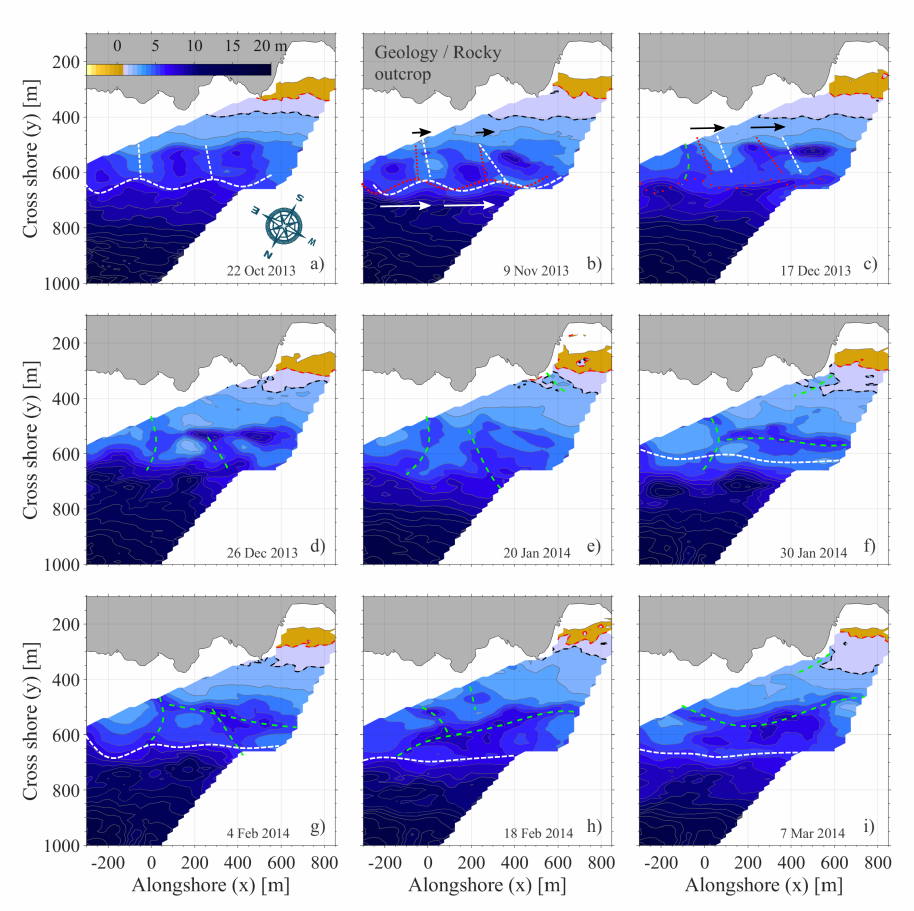
Figure 4. Video-derived bathymetry sequence, ( a – i ), covering a period starting from 22 October 2013 ( a ) to 7 March 2014 ( i ). In between this period the projected images show arbitrary days depending on image quality and visibility of morphological features: ( b ) 9 November 2013, ( c ) 17 December 2013, ( d ) 26 December 2013, ( e ) 20 January 2014, ( f ) 30 January 2014, ( g ) 4 February 2014 and ( h ) 18 February 2014. The main morphological features are highlighted: sub-tidal bar is represented by the white dashed line, the green dashed lines indicate the positions of rip channels and the alongshore migration of morphological features